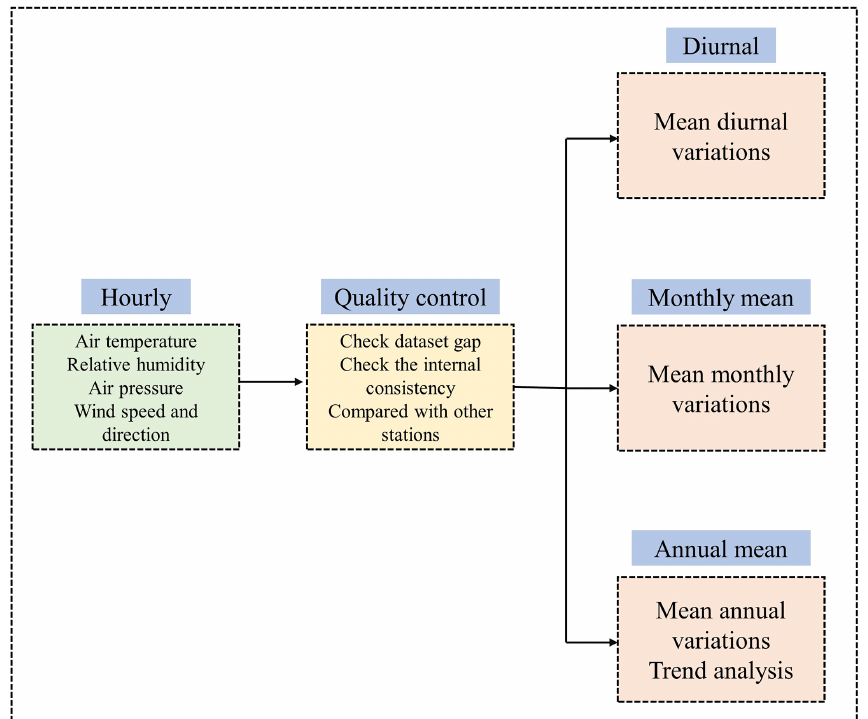
Figure 2. Schematic diagram of the data-processing workflow used to compile the AWS meteorology dataset for the network.